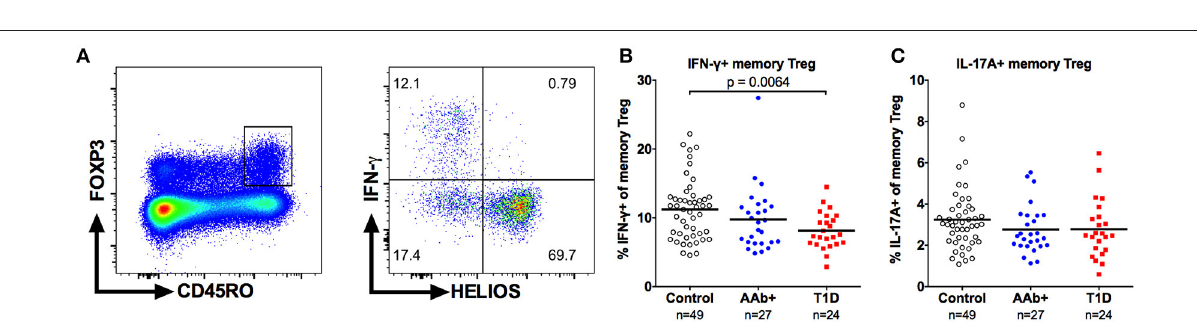
with T1D using multiple different approaches to define